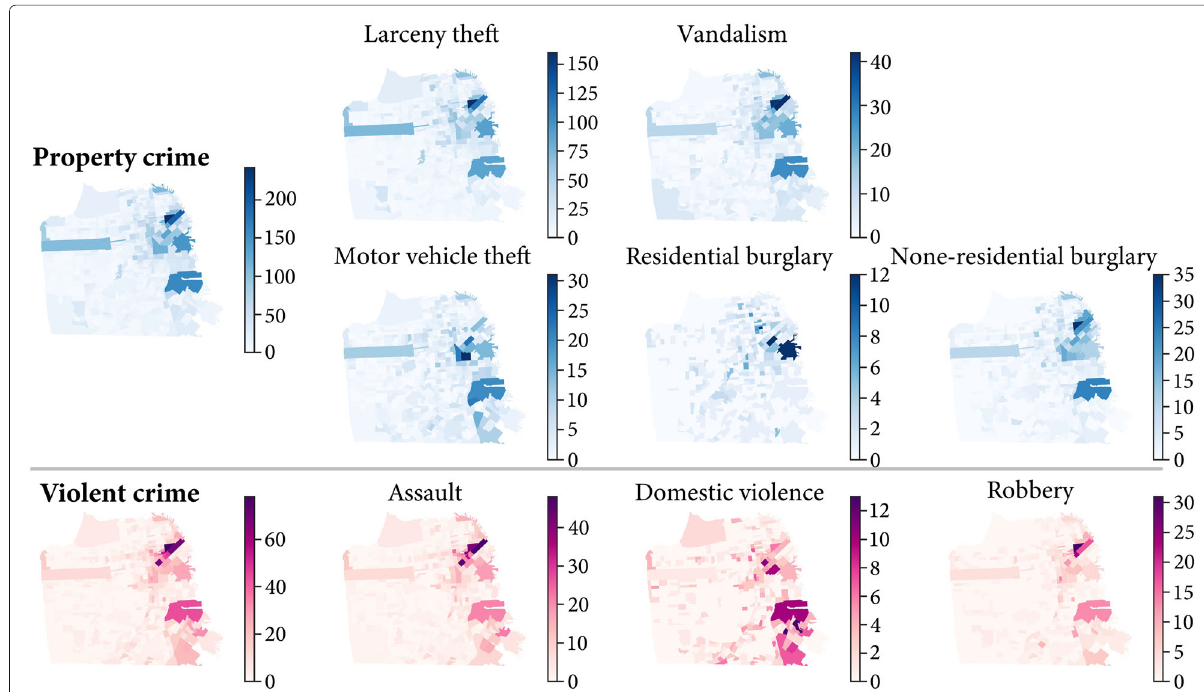
Fig. 3 Spatial distribution of crime in different types at CBG-level during the sixth observation timespan ( TO 6 ) (Feb. 7 to Apr.